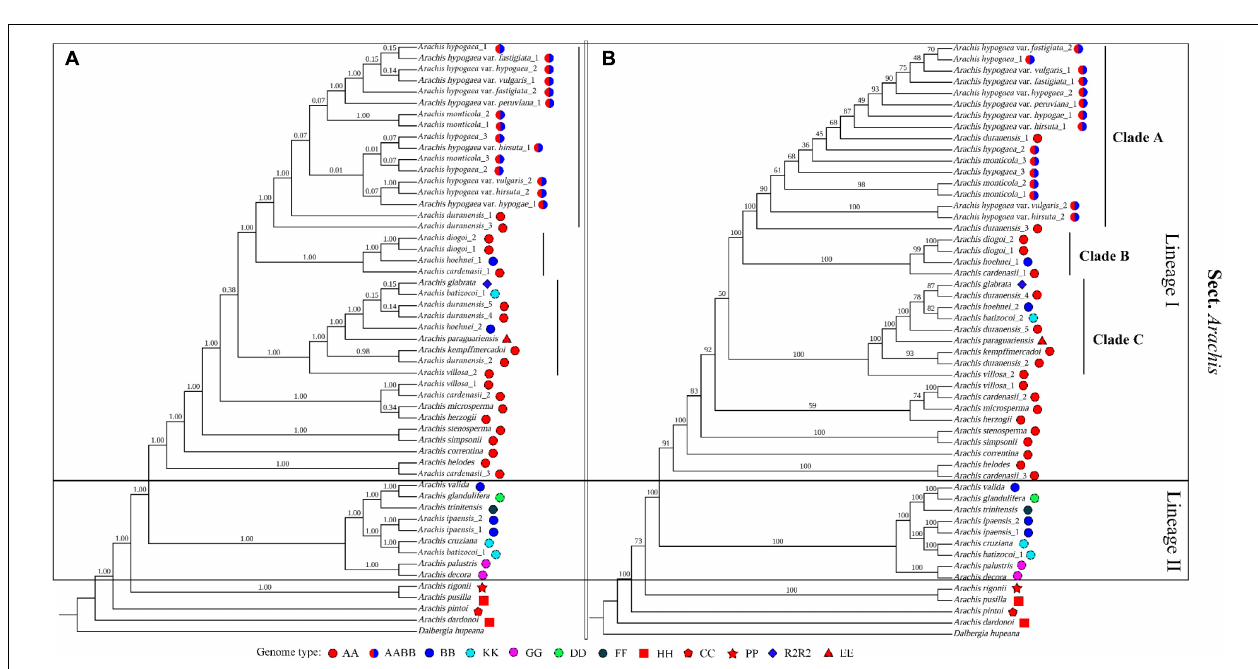
FIGURE 4 | Phylogenetic trees constructed with 52 Arachis plastomic sequences using the Bayesian inferred (A) and Maximum likelihood (B) methods. Numbers above the branch represent the confidence level.